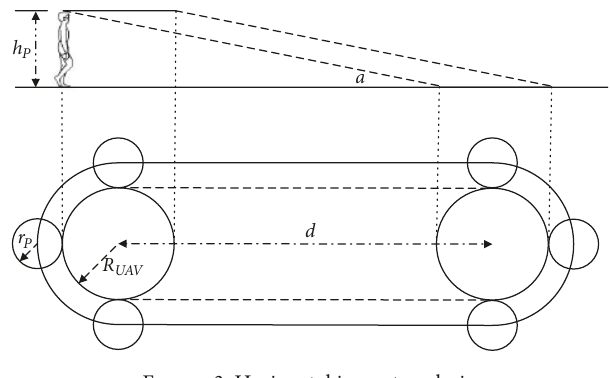
Figure 3: Horizontal impact